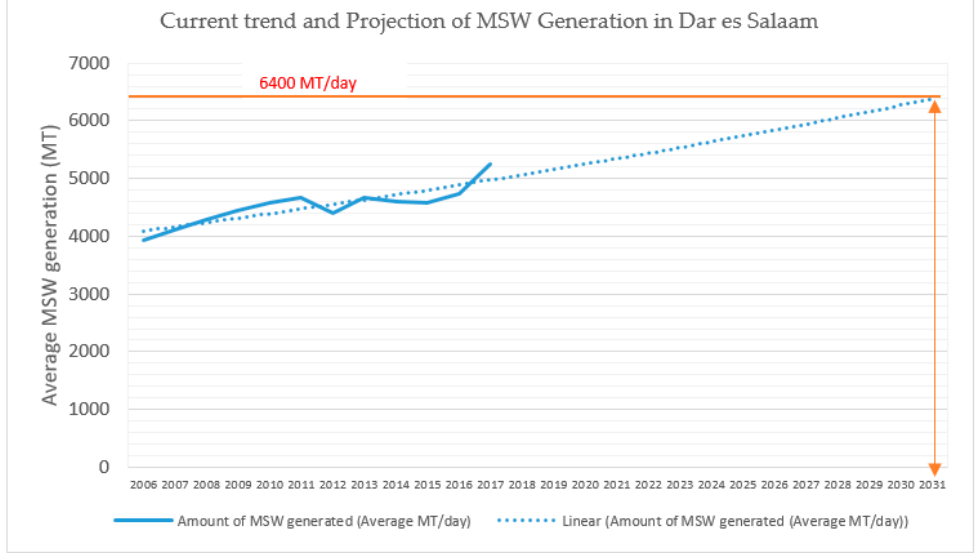
Figure 2. Trend and projection in municipal solid waste generation.